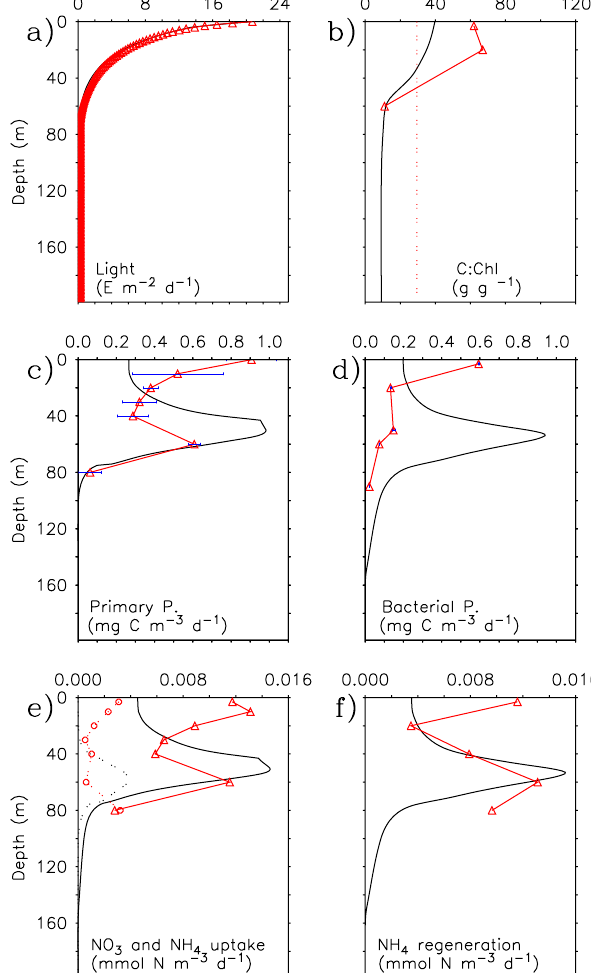
Fig. 8. Model–data comparisons (rates) for the “no photoammoni- fication” run. Model outputs are in black and observations in red: (a) downwelling PAR, (b) C:Chl ratio (for SP in the model; for the observations derived from Claustre et al.,1999 (see text for details); the vertical dashed line is the mean C:Chl ratio according to Du- Rand et al., 2002, and Sherr et al., 2003), (c) primary production, (d) bacterial production, (e) NH 4 and NO 3 uptake (in the model, full and dashed lines, respectively; in the observations, triangles and circles, respectively) and (f) NH 4 regeneration. In (c) and (d) , the averages ± standard deviation appear in